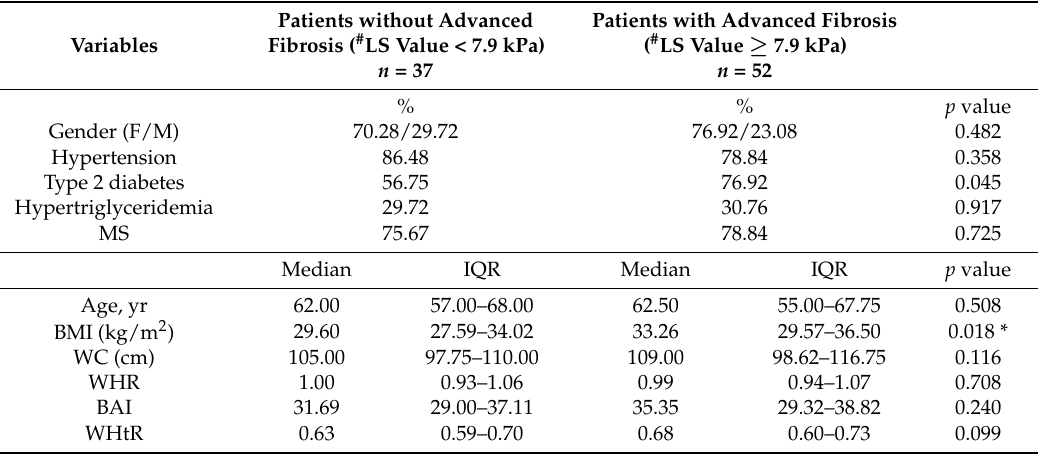
Table 1. Characteristics of the study